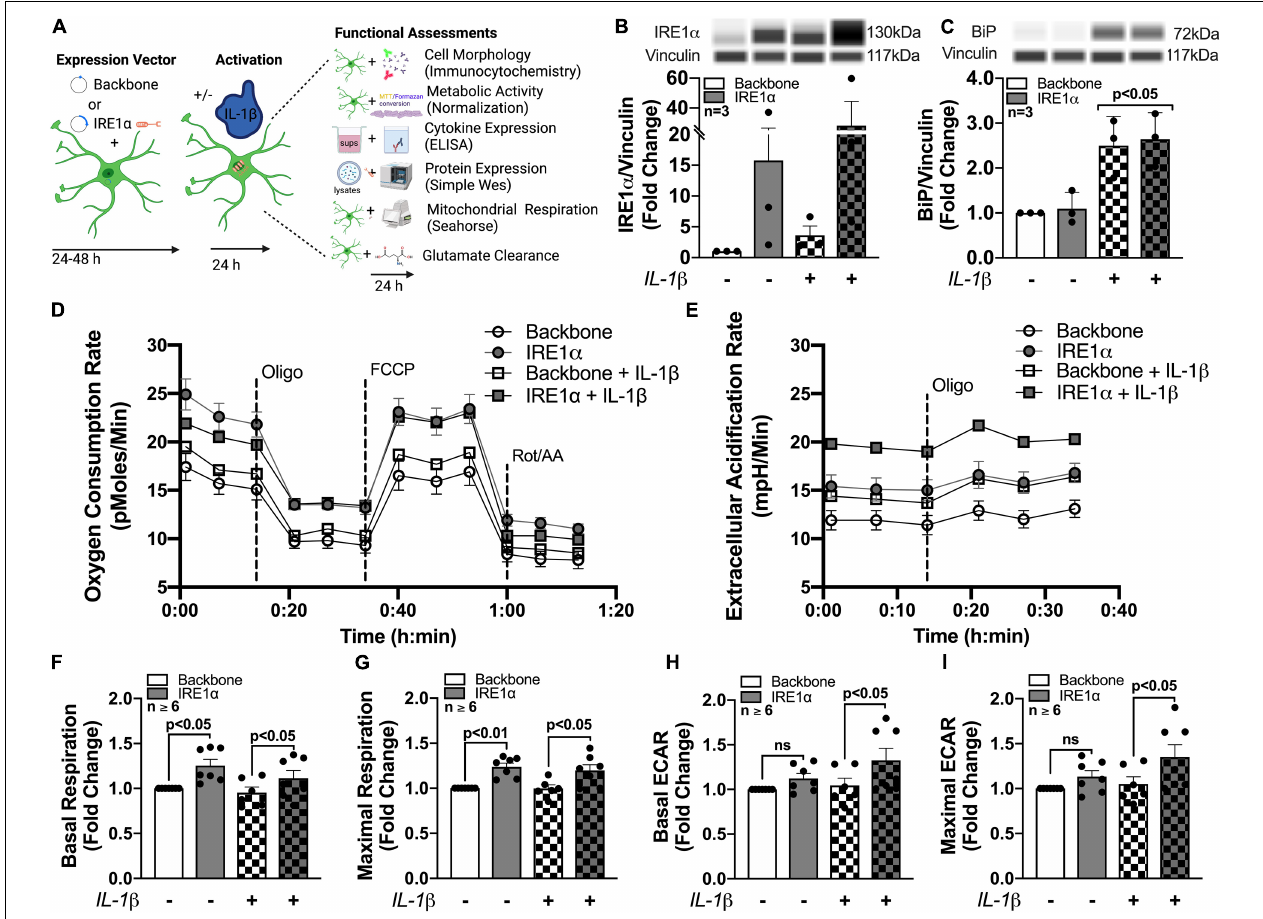
FIGURE 6 | Astrocyte IRE1 α regulates both mitochondrial respiration and glycolytic activity through distinct mechanisms. (A–I) Astrocytes were transfected with an IRE1 α overexpression vector (gray bars) or backbone (white bars) and then treated with IL-1 β for 24 h (checkered bars) prior to functional assessments. (B,C) Cellular lysates were collected and assayed by Simple Wes to quantify (B) IRE1 α and (C) BiP expression levels. Vinculin was used as an internal control. (D,F,G) Mitochondrial respiration and (E,H,I) glycolytic activity were assessed by Seahorse metabolic assay. (D) OCR and (E) ECAR profile tracings from a representative astrocyte donor were graphed over time. Fold changes in (F) basal respiration, (G) maximal respiration, (H) basal ECAR, and (I) maximal ECAR were graphed for statistical comparisons. Individual dots on graphs represent the averaged data from a minimum of 6 replicates per biological donor. Significance was determined by one-way ANOVA and Tukey’s post hoc for multiple comparisons. Experimental Illustration was made with